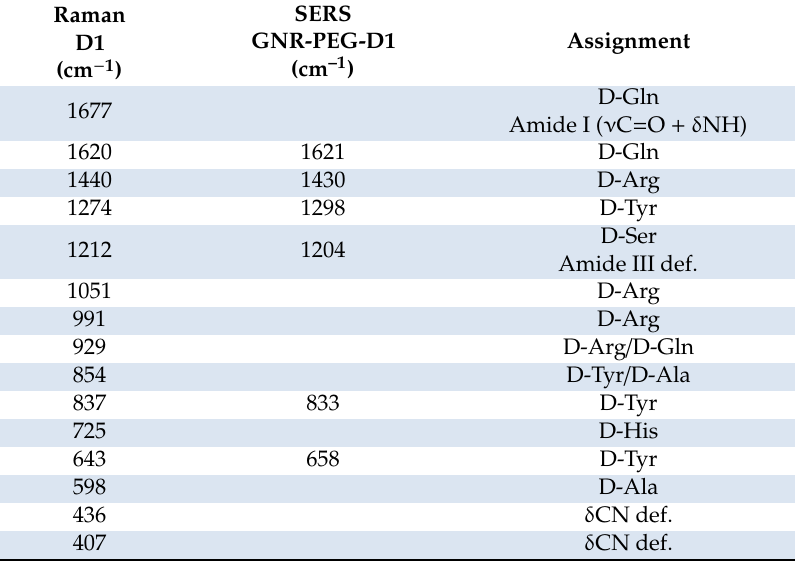
Figure 5. SERS spectrum of the D1 peptide using GNR-PEG-D1 (blue line) and Raman spectrum of D1 peptide (black line). (*: PEG bands). Table 1. Raman and SERS signals assignment for D1 and GNR-PEG-D1. D-Arg: arginine; D-Tyr: tyrosine; D-Ser: serine; D-Gln: glutamine; D-Ala: alanine; D-His: histidine. ν: stretching. δ: bending. def.: deformation. The stretching mode ( ν ) is associated with the change in the continuum interatomic length of a couple of bonded atoms, while the bending mode ( δ ) is related with the change of an angle that is formed by two bonds.